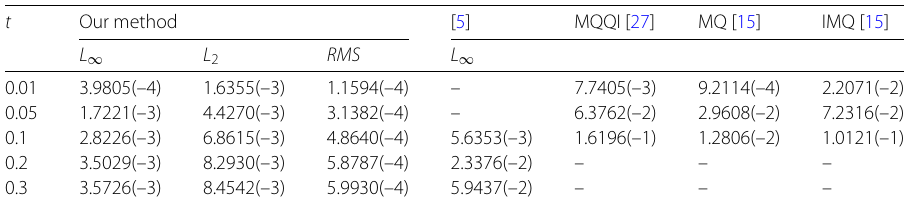
Table 8 Errors for p = 10, σ = 1 Example